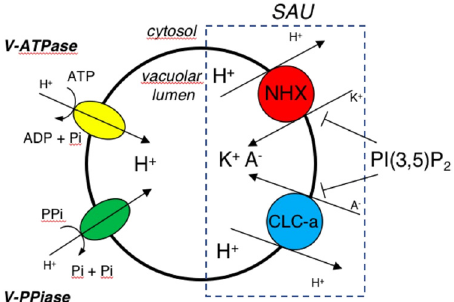
Figure 4: Schematic representation of the key players in vacuolar salt uptake. A salt accumulation unit is formed by NHXs together with CLC - a. V - ATPase: vacuolar H + - ATPase; V - PPiase: vacuolar H + - pyrophosphatase. A − , H + , and K + indicates, respectively, anions, protons, and potassium ions; the dimension of the letters is pro - portional to their concentration. Modi fi cation of Figure 6c from Gradogna et al. [ 57 ] , New Phytologist , 229:3026 – 36, reprinted